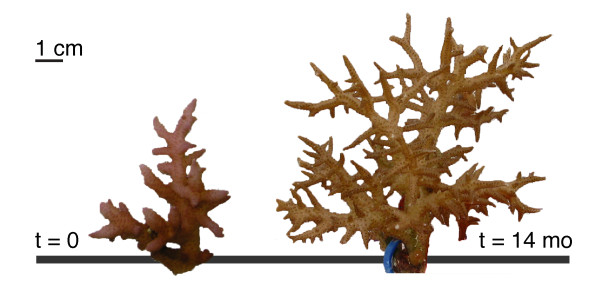
Growth example of transplanted fragment. Example of growth during the transplantation period (14 months) of a fragment transplanted back to the 'Deep Slope' habitat.